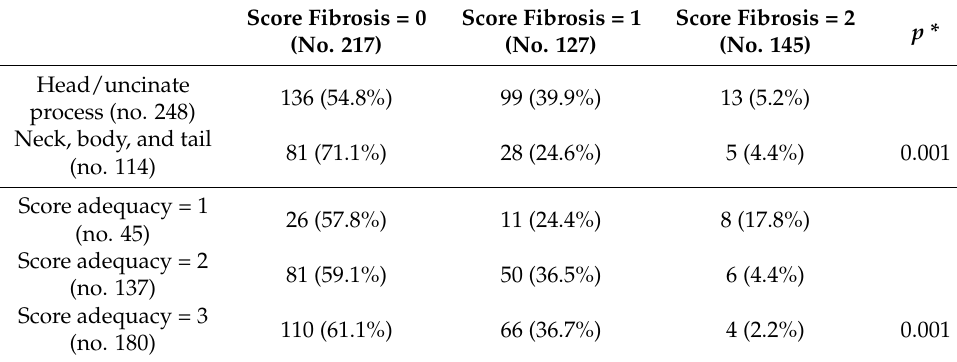
Table 7. Fibrosis distribution according to tumor location (head/uncinate process vs. neck, body, and tail) and according to specimen adequacy. Score Fibrosis = 0 Score Fibrosis = 1 (No. 217) process (no. 248) Neck, body, and tail